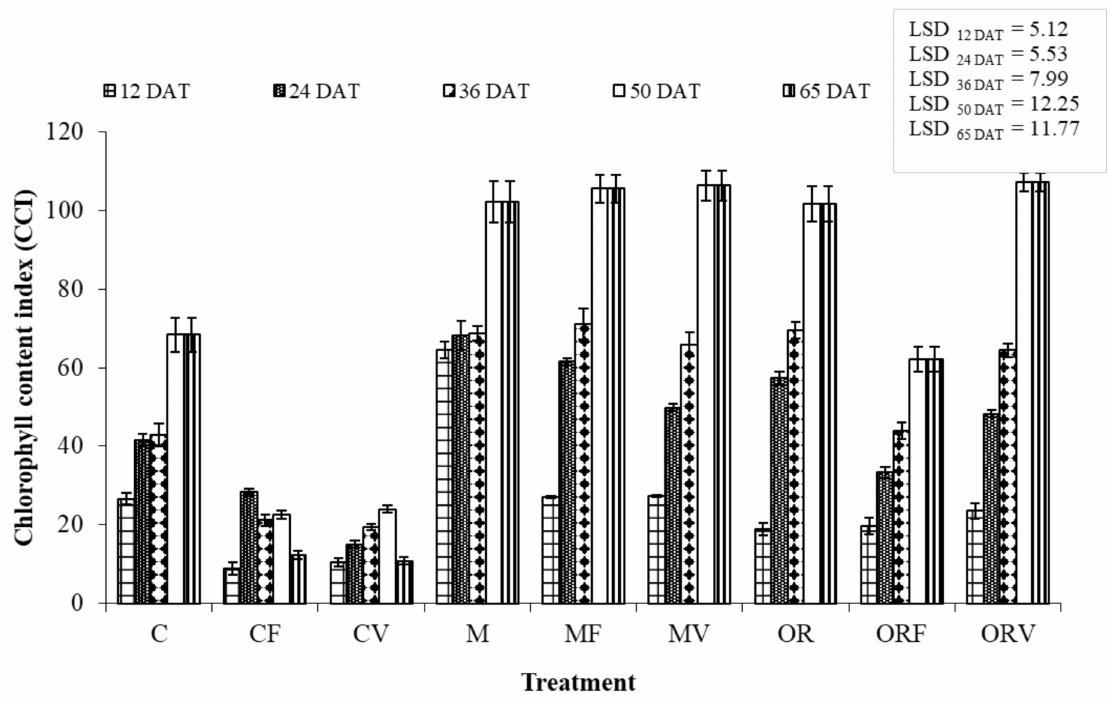
Figure 5. Chlorophyll content index (CCI) (means ± se) of healthy and inoculated transplanted tomatoes grown in soil amended with 4% (w / w) of spearmint or oregano plant material. Determination was made at 12, 24, 36, 50 and 65 days after the transplantation (DAT), whereas each mean represents the average of 24 determinations [12 replications (plants) × 2 experiments]. Full description of the treatments examined is found in Table